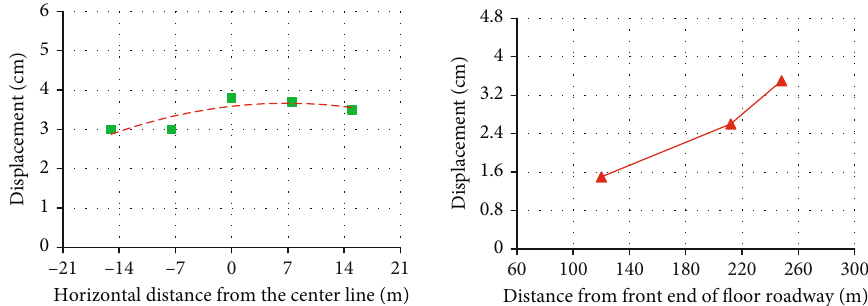
Figure 16: Curve chart of maximum displacement of surrounding rock in 213 fl oor roadway of Qujiang Coal Mine.